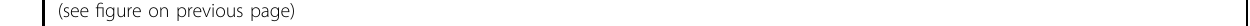
Fig. 4 Assessing the neuronal activity of the olfactory bulb, medial prefrontal cortex, piriform cortex and entorhinal cortex induced by the olfactory WM capacity (OWMC) task in 3-month-old 5 × FAD and wild-type (WT) mice. A Experimental procedure. B Representative images showing Fos protein in the olfactory bulb, medial prefrontal cortex, piriform cortex and entorhinal cortex in different experimental conditions. Scale bars represent 50 μ m. C Fos protein expression in the olfactory bulb, medial prefrontal cortex, piriform cortex and entorhinal cortex under different experimental conditions. OWMC-induced medial prefrontal cortex and entorhinal cortex activation is reduced in the medial prefrontal cortex of 5 × FAD mice. n = 4 – 5 per experimental condition. Data are the mean ± SEM of the number of Fos. # Compared with the ‘ No task ’ group, two-way ANOVA, p < 0.05. *Compared with the WT group, two-way ANOVA, p <